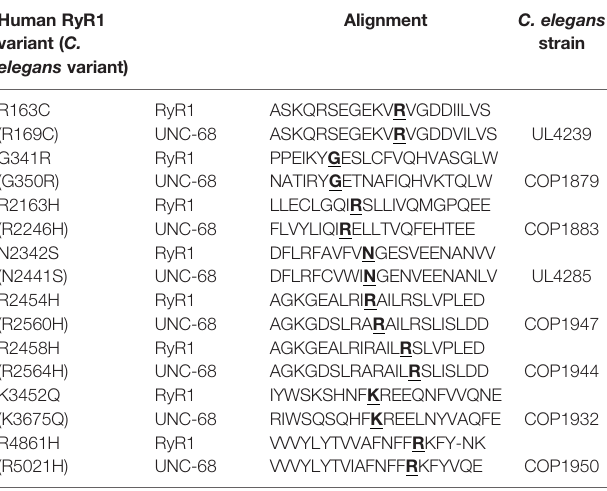
TABLE 1 | Amino acid alignment of human RyR1 and C. elegans UNC-68 in the regions of the studied variants, and the C. elegans strain expressing the variant